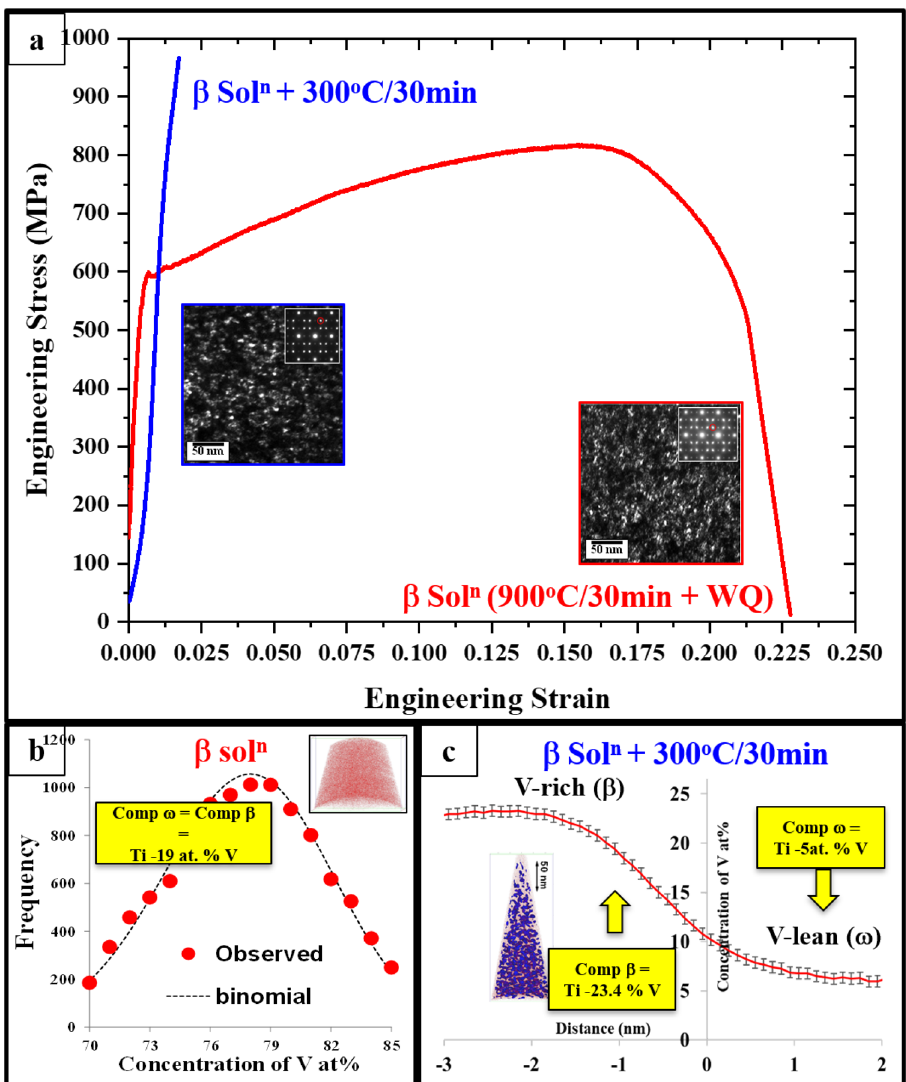
Figure 7. ( a ) Tensile test curves and Dark-field TEM (DFTEM) images of the β-solutionized condition (red curve) and the β-solutionized and annealed condition (blue curve). Insets show the [011] β electron diffraction patterns used for DFTEMs recording, ( b ) atom probe tomography (APT) results showing the binomial distribution comparison of V concentrations in β-solutionized specimen, ( c ) shows the 1D composition profile plot for V partitioning across ω/β interface (the inset shows the isoconcentration